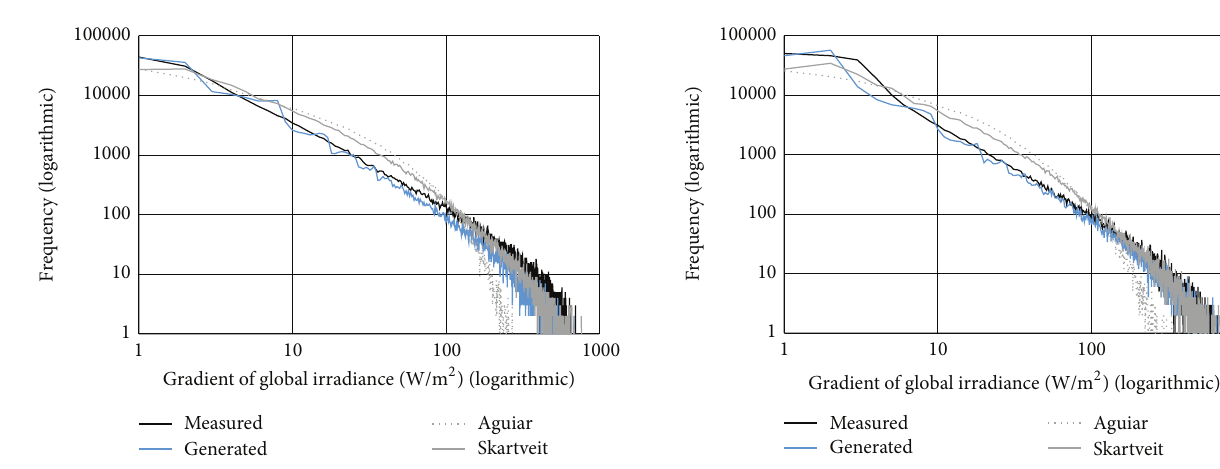
Figure 7: Frequency of gradients of the global irradiance in Carpentras, France (2001). As in Figure 6, the differences of the models for gradient values of less than 10 W/m 2 are comparable. In the range of 10 to 100W/m 2 , the new model (blue) shows a better congruence with the measured data (black) than the models of Aguiar and Skartveit (grey), while only the model of Aguiar fails to produce good congruence for gradient values of more than 100 W/m 2 . Table 4: Root mean square error (RMSE) values comparing the frequency distributions of the existing and the new algorithms with measured data. Smaller values of RMSE denote better congruence of the frequency distributions of modelled one-minute values with measured values. RMSE of irradiance in % RMSE of 𝑘 𝑡 in Model